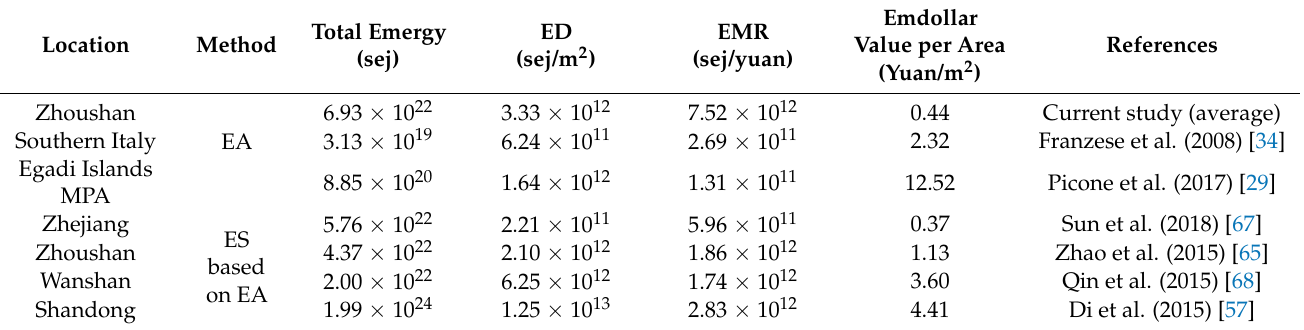
Table 6. Comparison of the accounting of marine natural capital from relative studies based on emergy-based